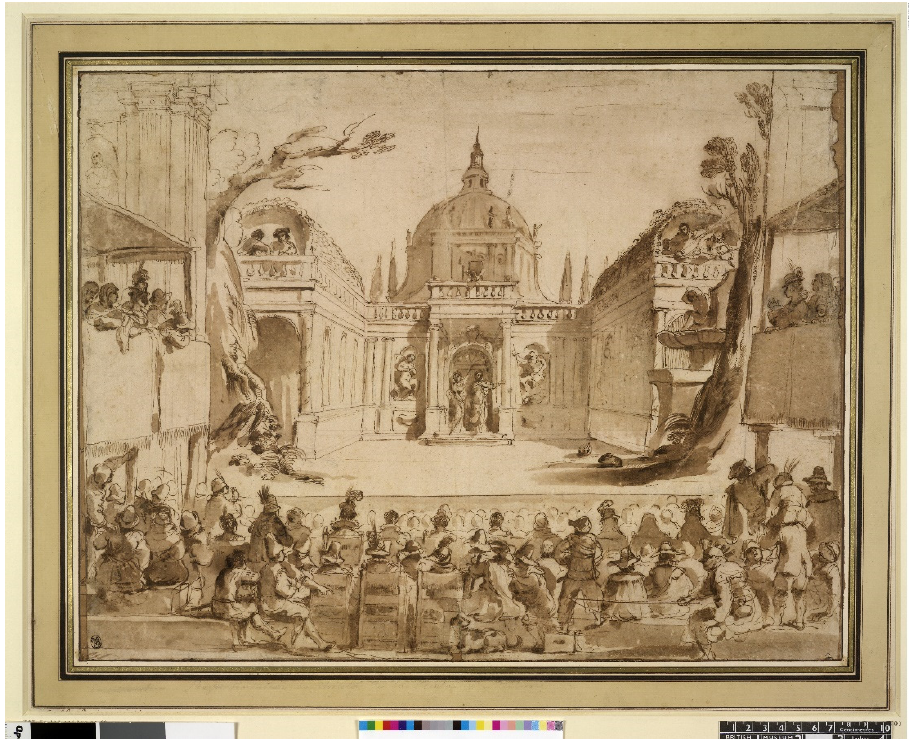
Figure 4. Guercino, A Theatrical Performance (drawing), 1617, The British Museum, London. Photo: © The Trustees of the British Museum.